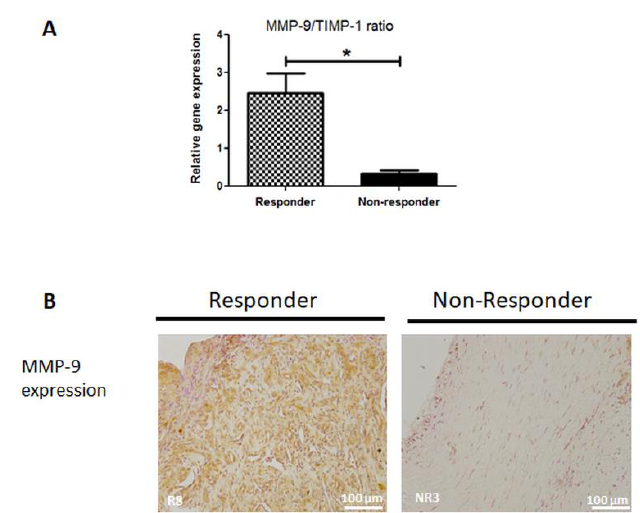
Figure 4. ( A ) Relative quantification of metalloproteinase-9 (MMP-9)/tissue inhibitor of metalloproteinases (TIMP-1) ratio mRNA in responder (R) and non-responder (NR) induced membranes. Data are expressed as the mean ± SEM, * p < 0.05. ( B ) MMP-9 immunolocalization in R and NR induced membranes. Scale bars = 100 µm.